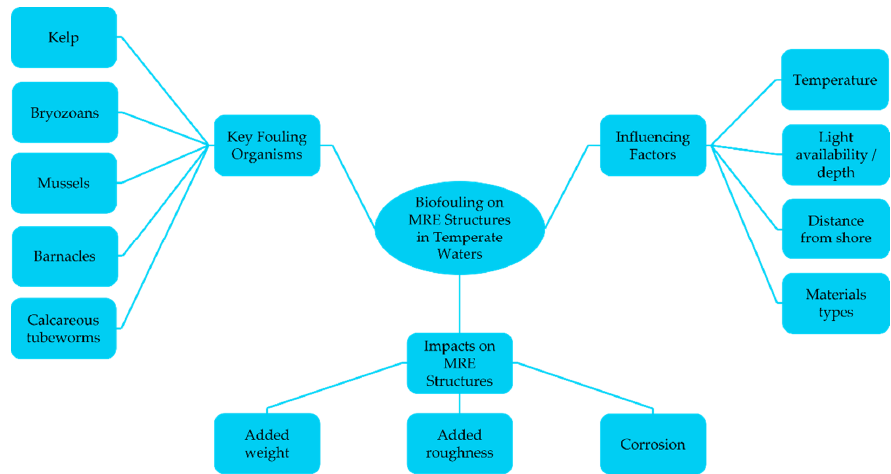
Figure 5. Illustration of findings from biofouling study performed by Vinagre et al.